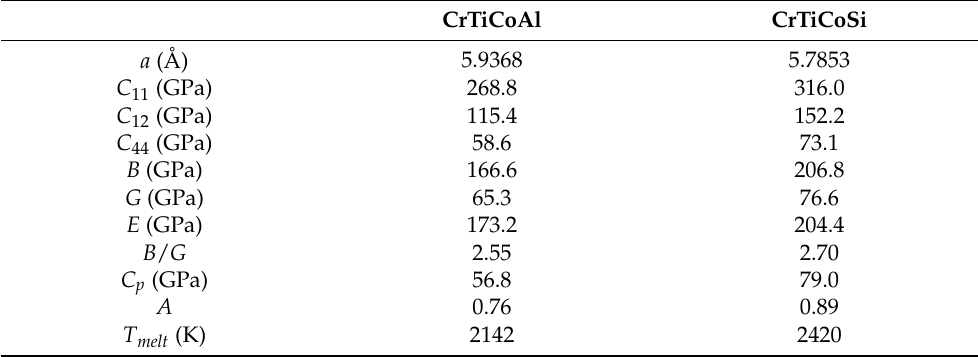
Table 4. Lattice constant and mechanical properties of Y-Type-III stable atomic configurations of CrTiCoAl and CrTiCoSi